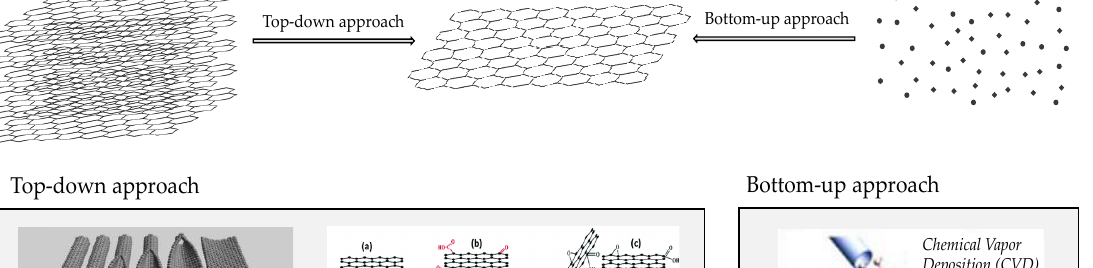
Top-down approach Bottom-up